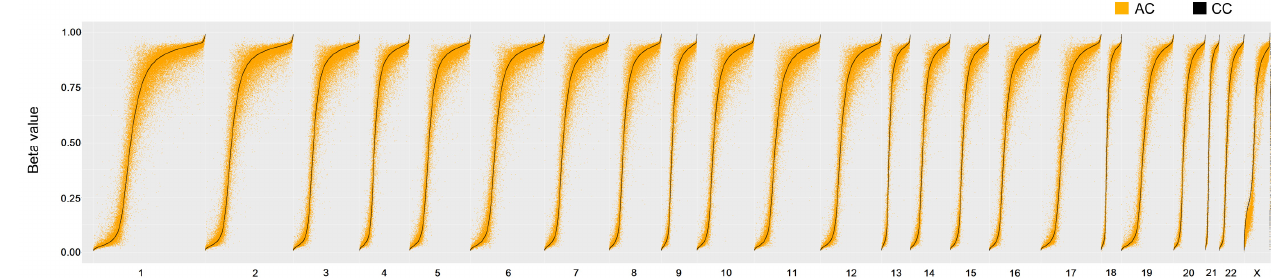
Figure 1. Scatter plot of neonatal and adult CpG methylation in chromosomes. We determined β -values (methylation proportion) of CpG dinucleotides using M850K assays. Each CpG dinucleotide has one β cc and one β ac value. The former and the latter were derived from three CC and three AC samples, respectively, without L -arginine treatment. For each chromosome, we tabulated β cc and one β ac values by sorting the β cc values. Then, we made scatter plots ( X -axis: β cc; Y -axis: β ac). Although overall highly correlated, β cc and β ac values of specific CpG dinucleotides can vary substantially. CC and CT refer to cord blood CD4 + T cells without and with L -arginine treatment, respectively. AC and AT refer to adult blood CD4 + T cells without and with L -arginine treatment, respectively.